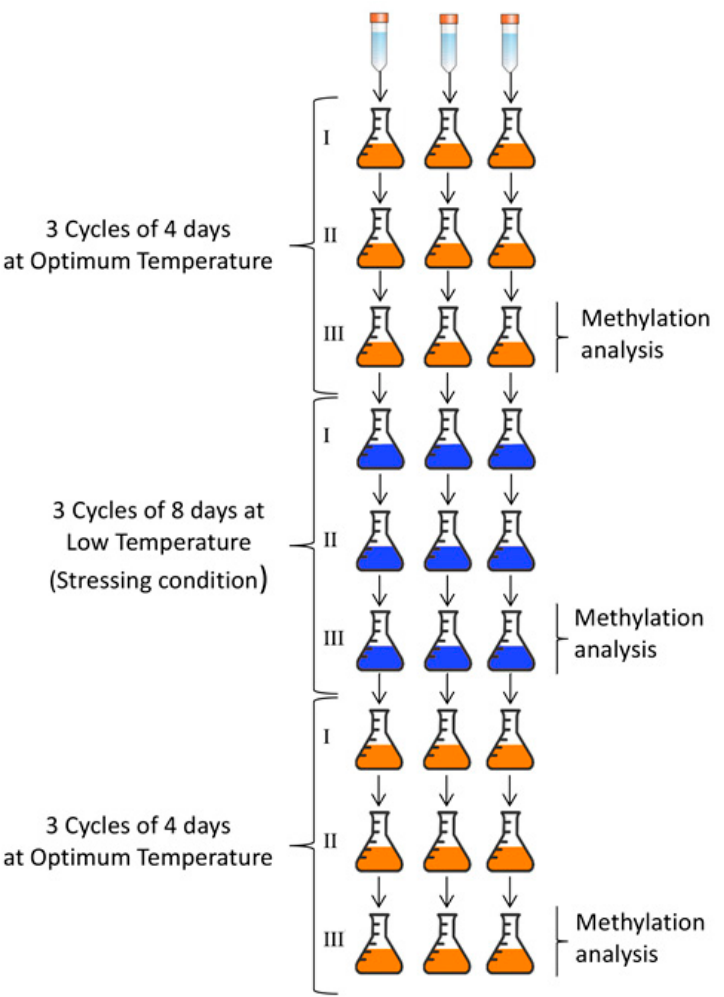
Figure 1. Experimental research design. The same procedure was applied in triplicate to both N. N. antarctica DBVPG 5271 and N. albida DBVPG antarctica DBVPG 5271 and N. albida DBVPG 10064.